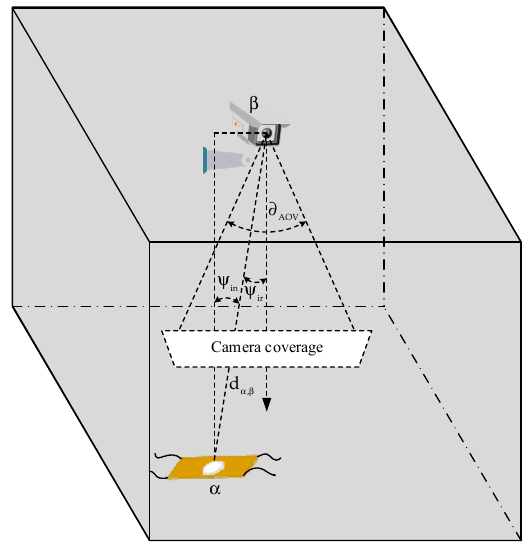
Figure 3. Optical channel model for OCC.